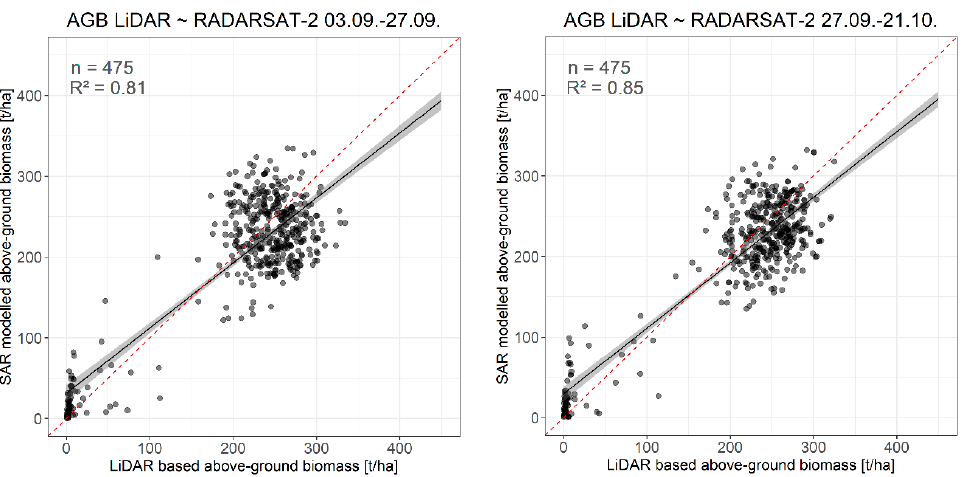
Figure 8. Correlation of reference LiDAR AGB and modelled RS-2 AGB based on an interferogram from 03.09.–27.09. (left) and 27.09.–21.10. (right). Red dashed line = 1:1 line; black line = linear trend including confidence bounds, n = 475.